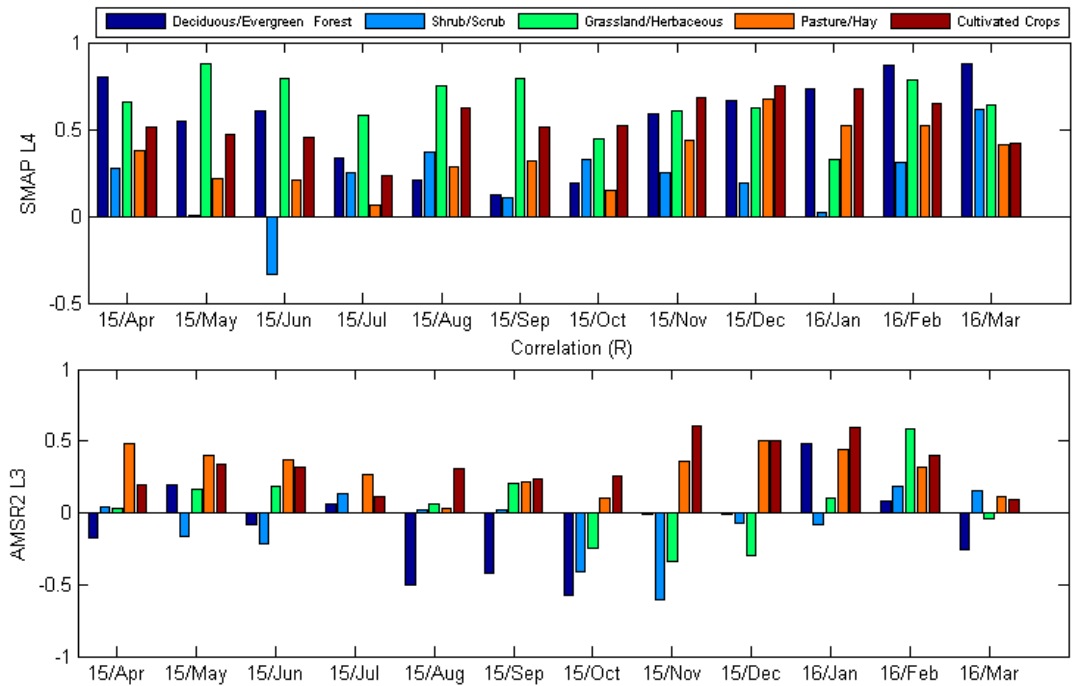
Figure 9. Temporal evolution of correlation between SMAP L4 or AMSR2 L3 monthly average data and in situ soil moisture data in the regions with different vegetation cover types of U.S.